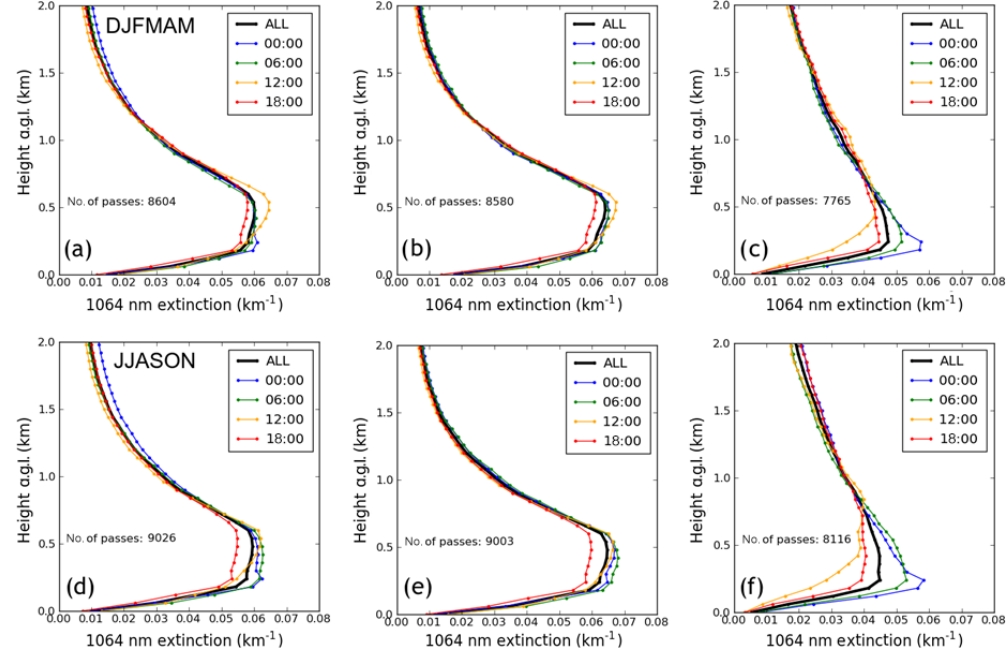
Figure 11. Global mean 6h (00:00, 06:00, 12:00 and 18:00LT) vertical profiles of CATS 1064nm extinction for (a) all DJFMAM profiles, (b) DJFMAM water profiles, (c) DJFMAM non-water profiles, (d) all JJASON profiles, (e) JJASON water profiles and (f) JJASON non-water profiles. Mean AODs are as follows: (a) 0.080, (b) 0.079, (c) 0.095, (d) 0.082, (e) 0.081 and (f)